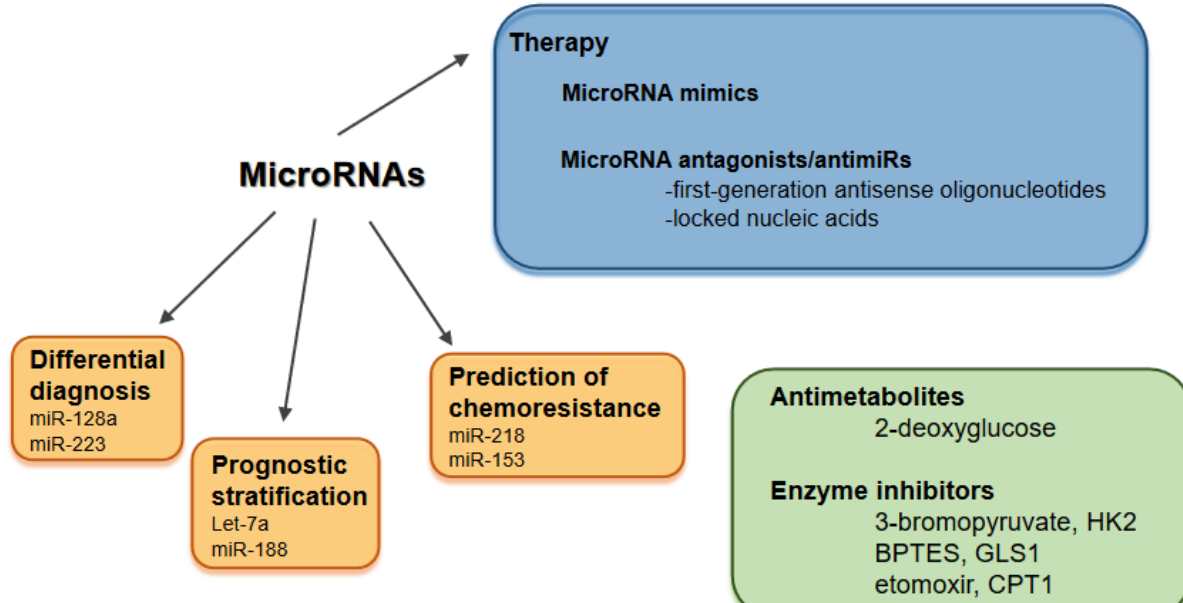
Figure 2. Clinical applications of microRNAs and therapeutic approaches to counteract Warburg effect. Abbreviations: BPTES: bis -2-(5-phenylacetamido-1,2,4-thiadiazol-2-yl)-ethyl-sulfide, CPT1: carnitine palmitoyltransferase-1, GLS: glutaminase enzyme, HK2: hexokinase 2 isoform.